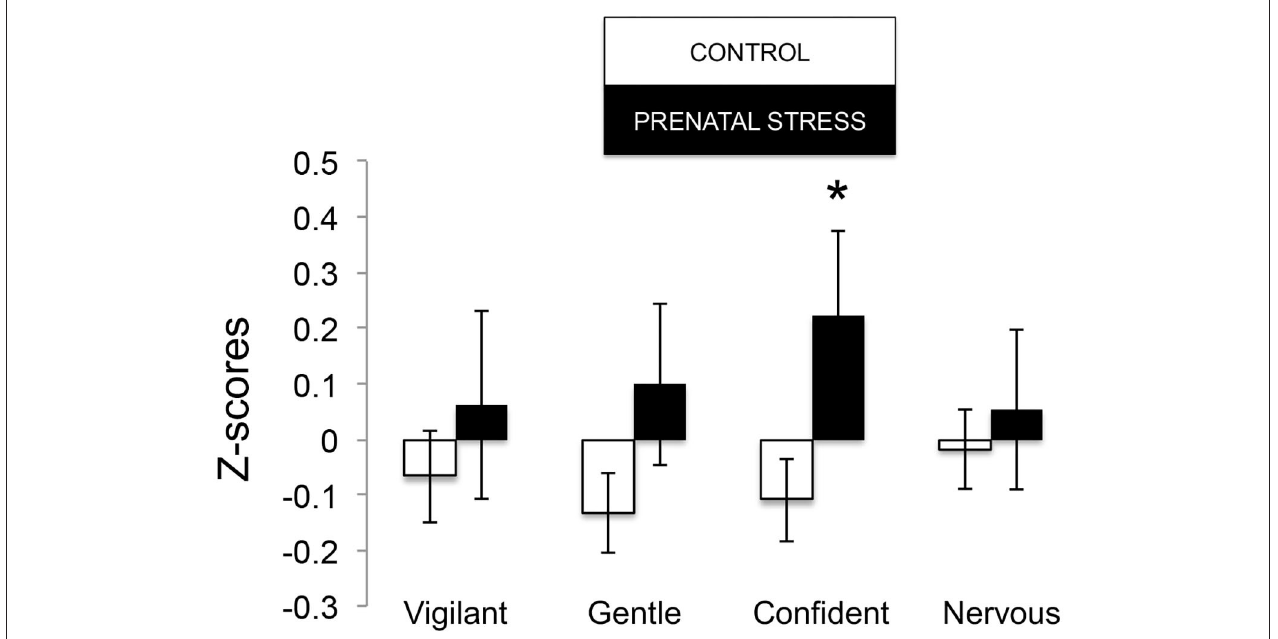
FIGURE 4 | Temperament measures during biobehavioral assessment between offspring of prenatally stressed mothers ( n = 39) and control mothers ( n = 149). Means are presented ± standard error of the mean. * p <